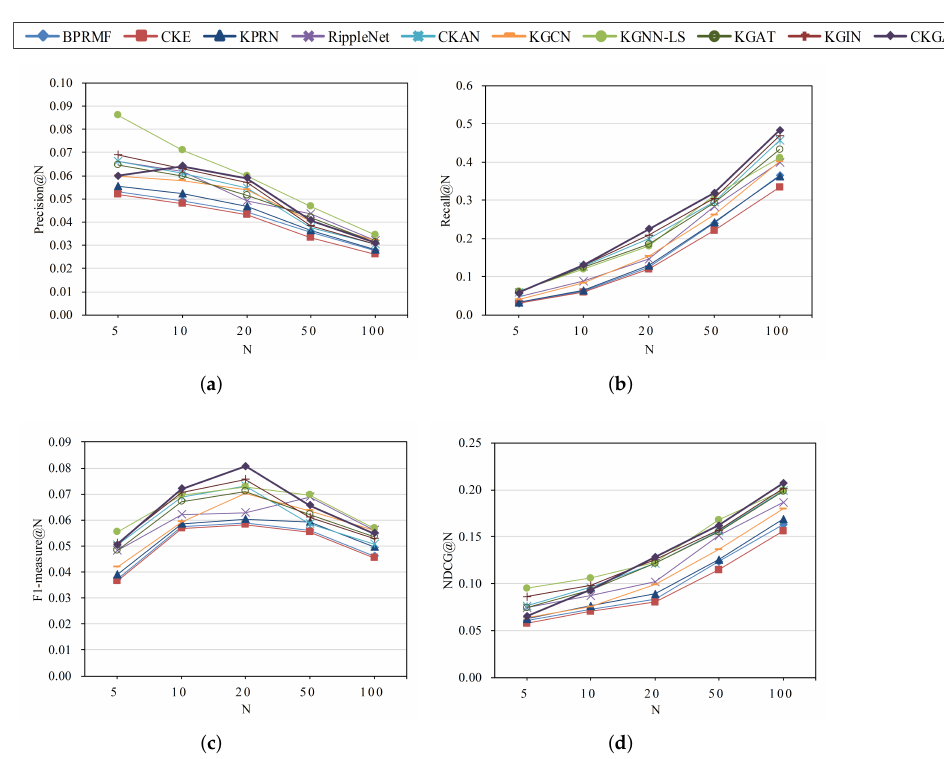
Figure 5. Top-N recommendation performance comparison on the MovieLens 20M dataset. ( a ) Prece-